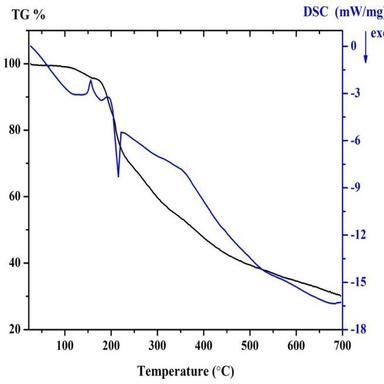
TG-DSC profile of LHFFAM.